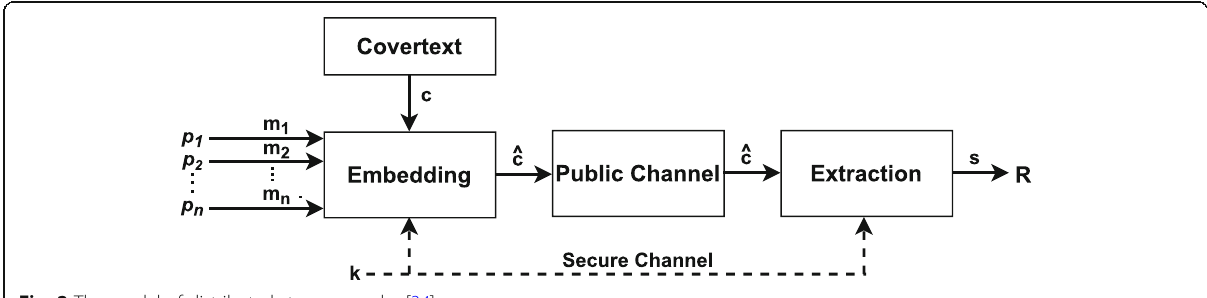
Fig. 2 The model of distributed steganography [34]